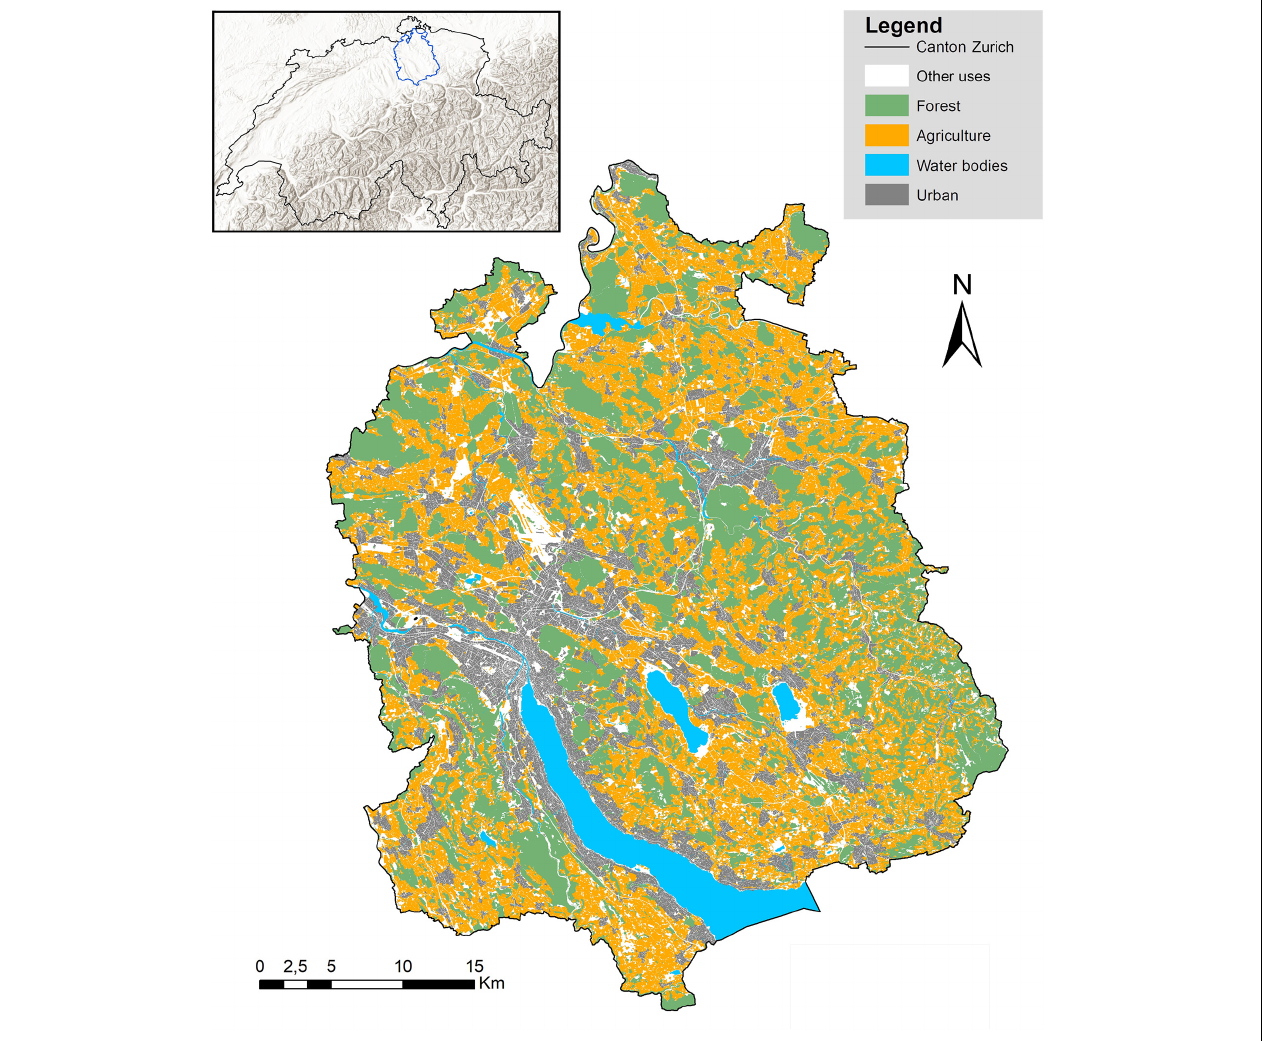
FIGURE 1 | Our study area is the Canton of Zurich (blue line in the inset at the top left), in Switzerland (black line in the same inset). The main land use types within the study area are agricultural, forest and urban land. Data from Amt für Landschaft und Natur (2010).